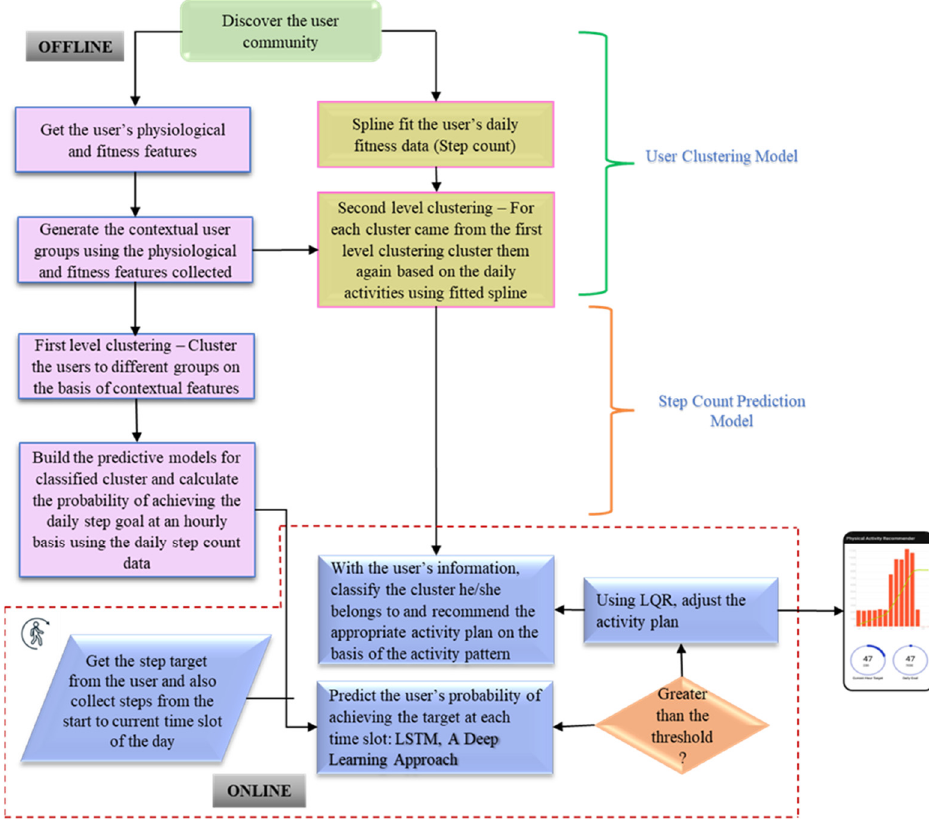
Figure 1. Flow chart of dynamic physical activity recommendation for fitness app.